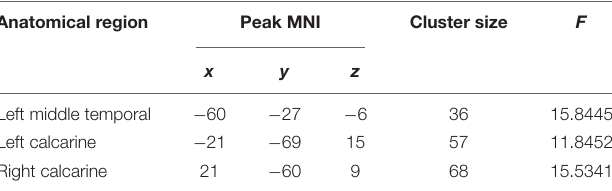
TABLE 5 | Regions with differences in the voxel-wise concordance of R-fMRI indices among the MDD with childhood trauma, MDD without childhood trauma, and HC